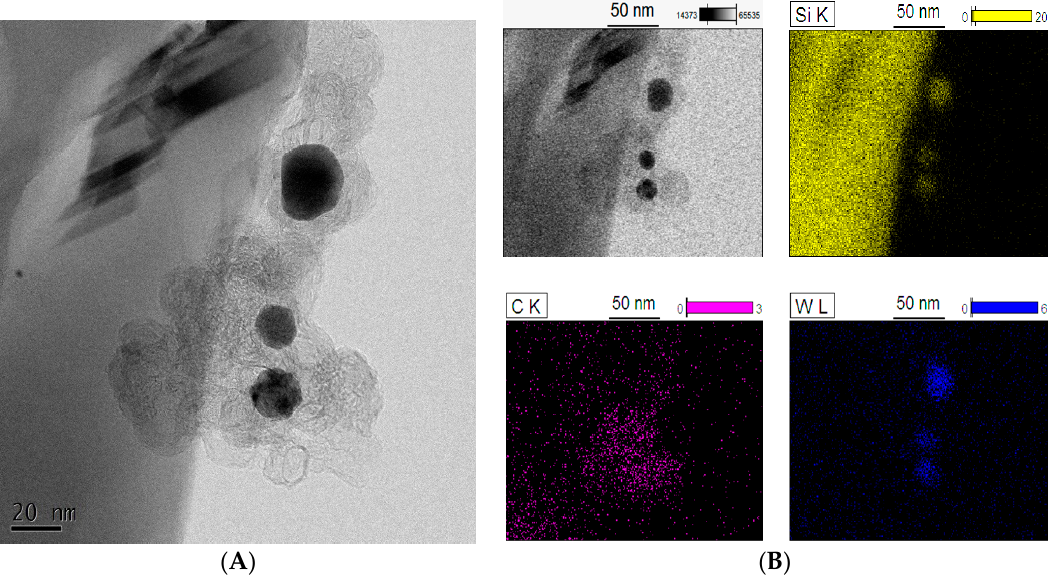
Figure 6. BF-TEM image ( A ) and EDS element maps ( B ) of (10) W x C- β -SiC composite.